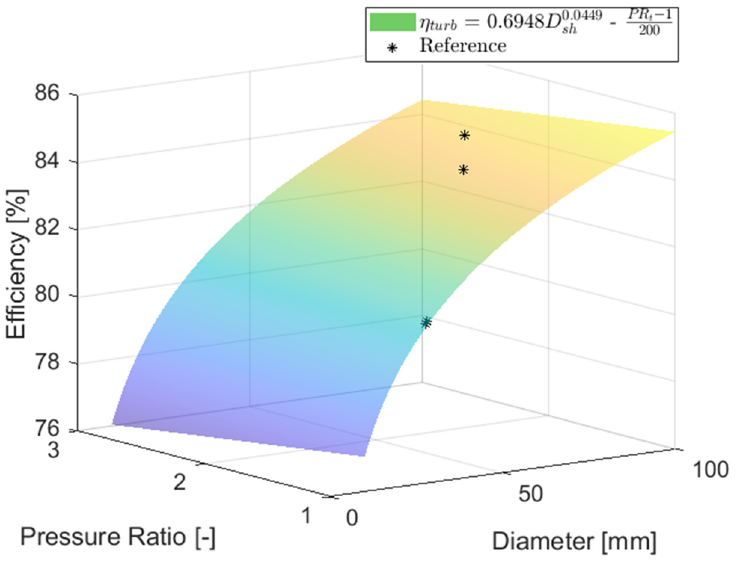
Figure 8. Comparison of turbine polytropic efficiency with S-CO 2 compressor experimental facility.